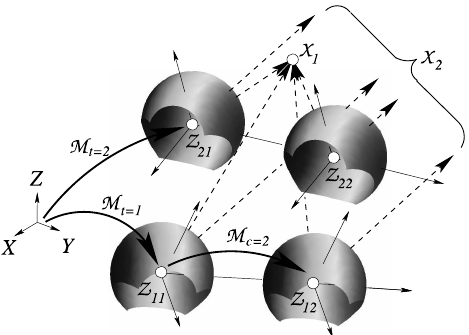
Figure 5: A two-camera system with fisheye cameras c = 1 , 2 with projection centers Z tc , rigid motion M c and time-varying motion M t , having a field of view larger than 180 ◦ shown at two exposure times t = 1 , 2 observing two points X i , i = 1 , 2 , X 1 being close by and X 2 at